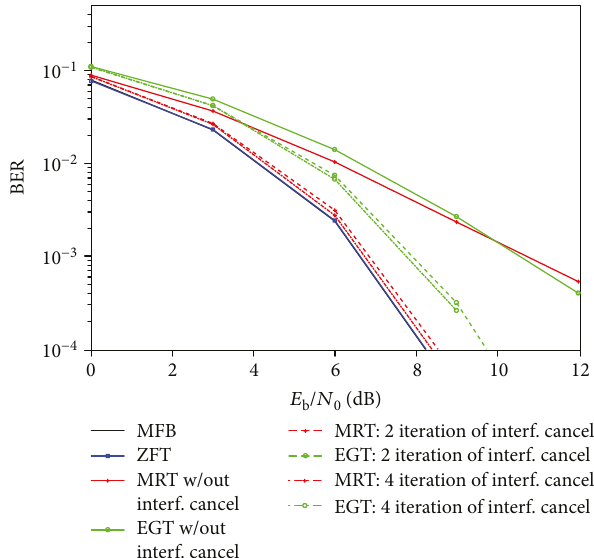
Figure 4: BER results with 32 × 2 using ideal channel